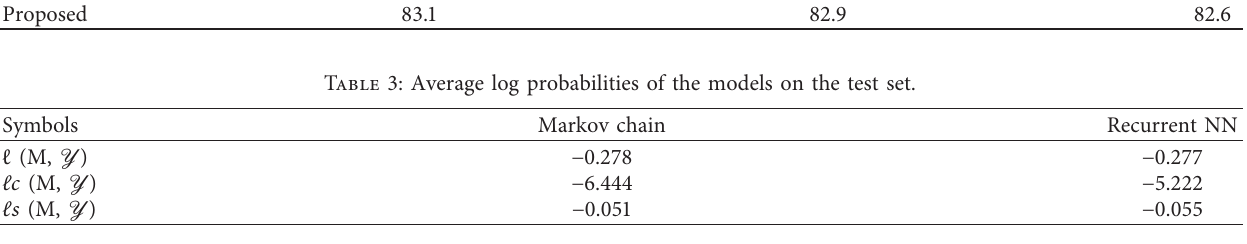
Table 4: Results of various training configurations of proposed model